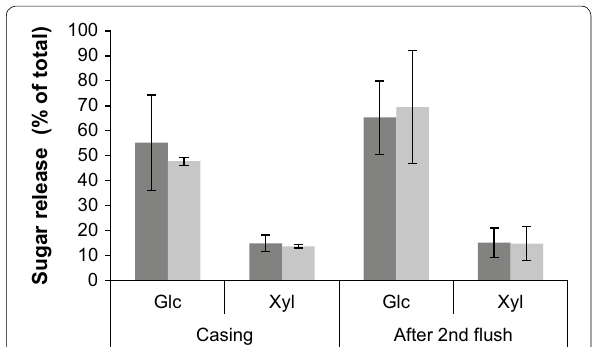
Fig. 4 Glucose (Glc) and xylose (Xyl) release after treating compost at casing and after the 2nd flush with cellulases and hemicellulases. Monosaccharide release is expressed as a percentage of the total corresponding carbohydrate. Error bars represent standard deviations based on four biological replicas